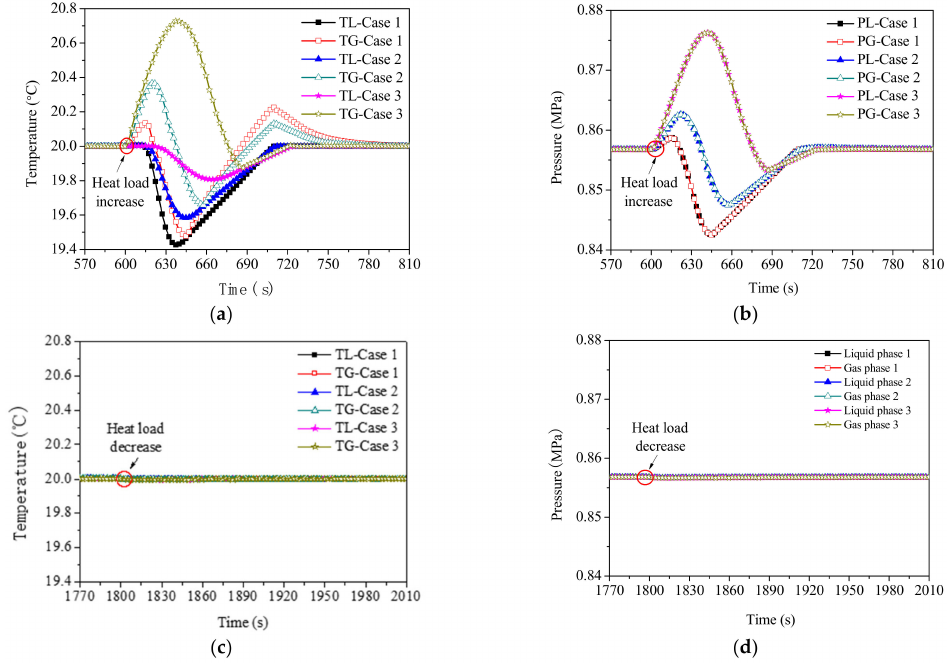
Figure 8. Temporal evolution of the temperature and pressure of the gas and liquid phases in the accumulator under different filling amount for heat power ( a , b ) increase and ( c , d ) decrease.